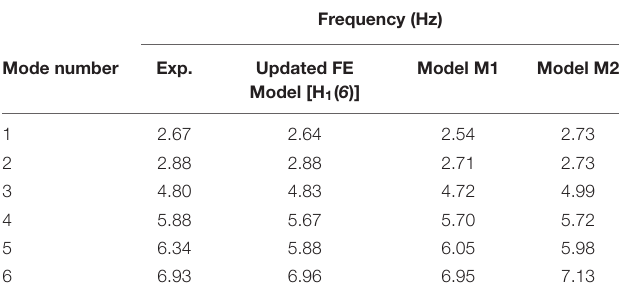
TABLE 3 | Comparison between experimental and numerical main frequencies.